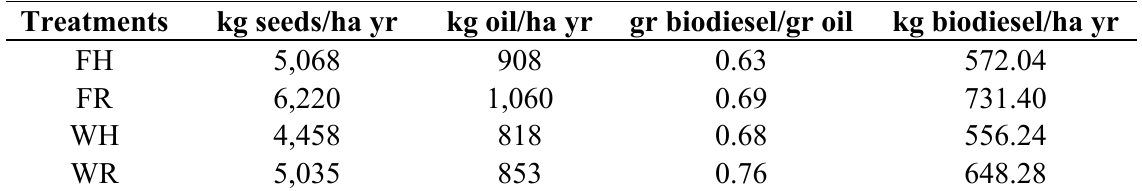
Table 3. Average values of seed, oil and biodiesel yields for different crops and irrigation